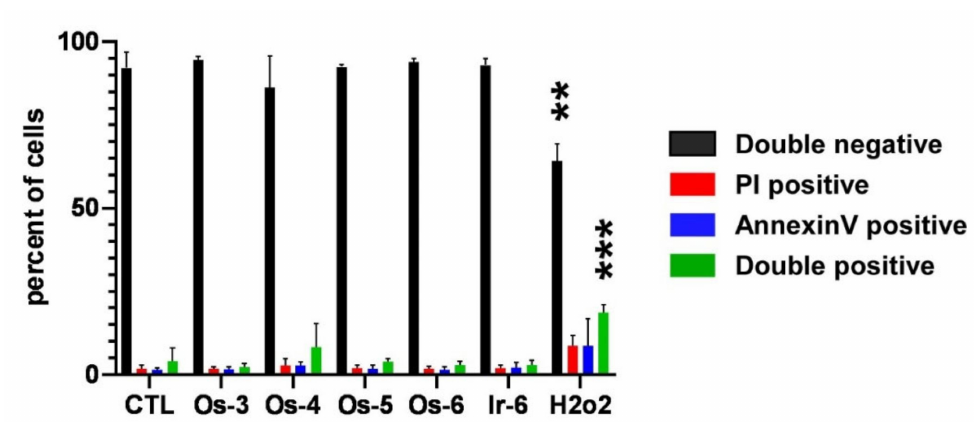
Figure 8. Complexes Os-3-Os-6 and Ir-6 did not induce cell death. Here, 1 × 10 6 A2780 cells were plated in 6-well plates and were treated with the corresponding complexes ( Os-3 at 2.68 µ M, Os-4 at 3.25 µ M, Os-5 at 2.84 µ M, Os-6 at 0.70 µ M, Ir-6 at 1.63 µ M,) and 300 µ M hydrogen peroxide for 2 h. Cells were then stained with Annexin V and propidium iodide (PI), then, cells were subjected to flow cytometry as described in the Materials and Methods section. The percentage of cells in the quadrants was plotted. Data are represented as average ± SD, from three biological replicates; individual assays were performed in duplicate. Normality was tested, on all datasets. A two-step transformation was used to achieve normal distribution. Statistical significance was determined using a two-way ANOVA test; all measurement points were compared with each other. ** and *** indicate statistically significant differences between vehicle-treated (control) and treated cells (ruthenium complexes or 300 µ M H 2 O 2 ) corresponding to the same quadrant (e.g., vehicle-treated double-negative cells vs. Os-3 -treated double-negative cells) at p < 0.01 and p < 0.001, respectively.